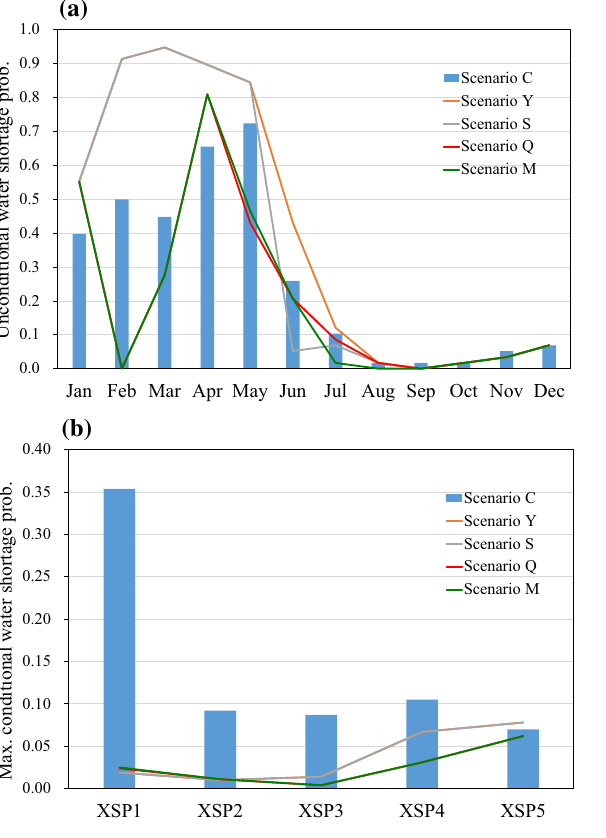
Fig. 3 a Unconditional water shortage probability of each month and b the maximum conditional water shortage probabilities of various lead times for current operation (scenario C) and various optimal sce- narios (Scenarios Y, S, Q, and M) of the Nanhua